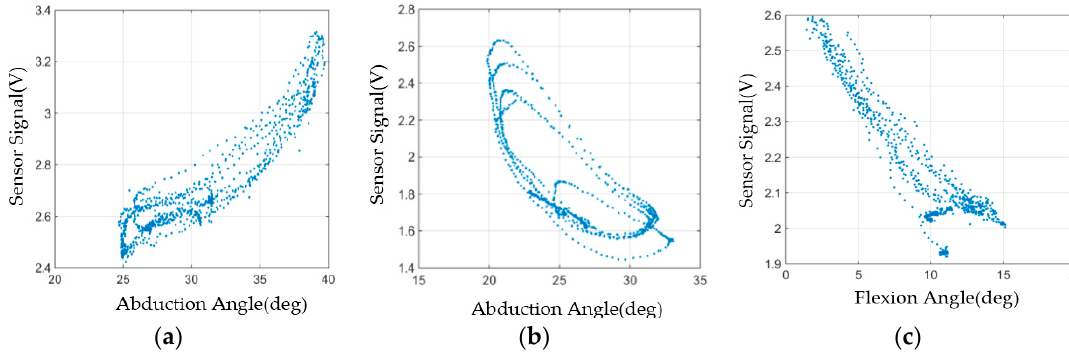
Figure 10. Sensor response with respect to the targeted CMC-joint angle with sensors located in the optimal positions during circumduction motion (rotation of the thumb along a circle): ( a ) CMC abduction sensor response with sensor in Location 1 (across second metacarpal); ( b ) CMC abduction sensor response with sensor in Location 2 (across adductor pollicis); ( c ) CMC flexion sensor response. Table 2. Normalized area at the optimal sensor locations.